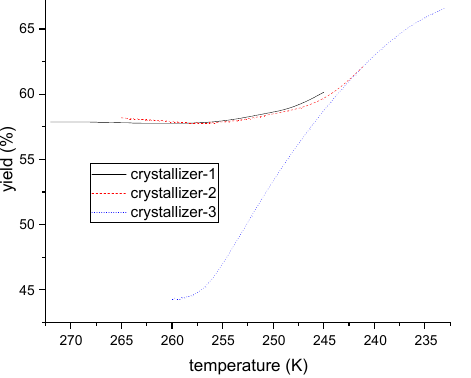
Figure 14. The relationship between PX yield and residence time of each crystallizer.